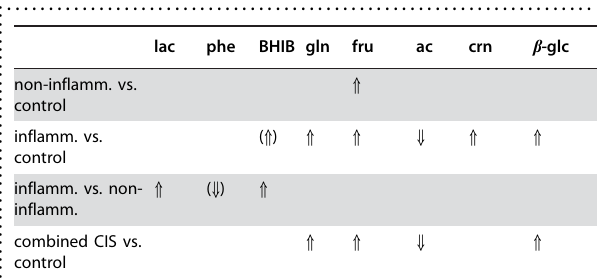
Table 2. Significant differences between individual CIS groups